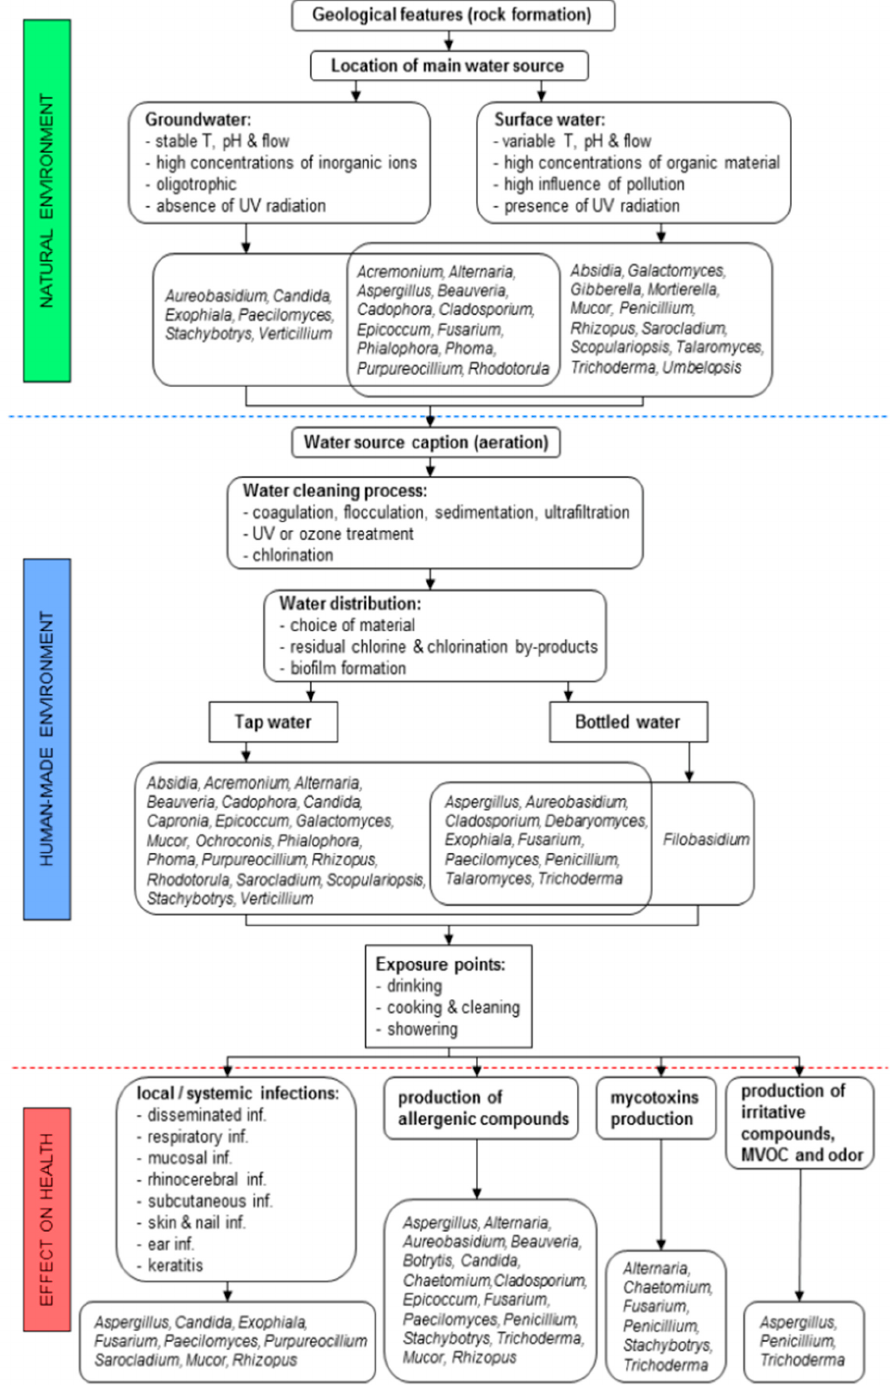
Figure 1. Abiotic, biotic, and anthropogenic factors influencing fungal presence in groundwater, surface water, tap water, and non-mineral bottled water, with a possible effect of fungi on human health via different exposure points. The most common factors having an influence on the fungal presence and diversity in different water sources are divided into factors influencing fungal presence, mainly in raw water sources in the natural environment (indicated with green colour), anthropogenic factors influencing fungal presence during the production of tap and non-mineral bottled water, and exposure points of fungi via water-related activities (indicated with blue colour). Red colour indicates the most frequently detected fungal genera from tap and bottled water with their possible effects on human health. Reproduced from [6], open access and with authors’